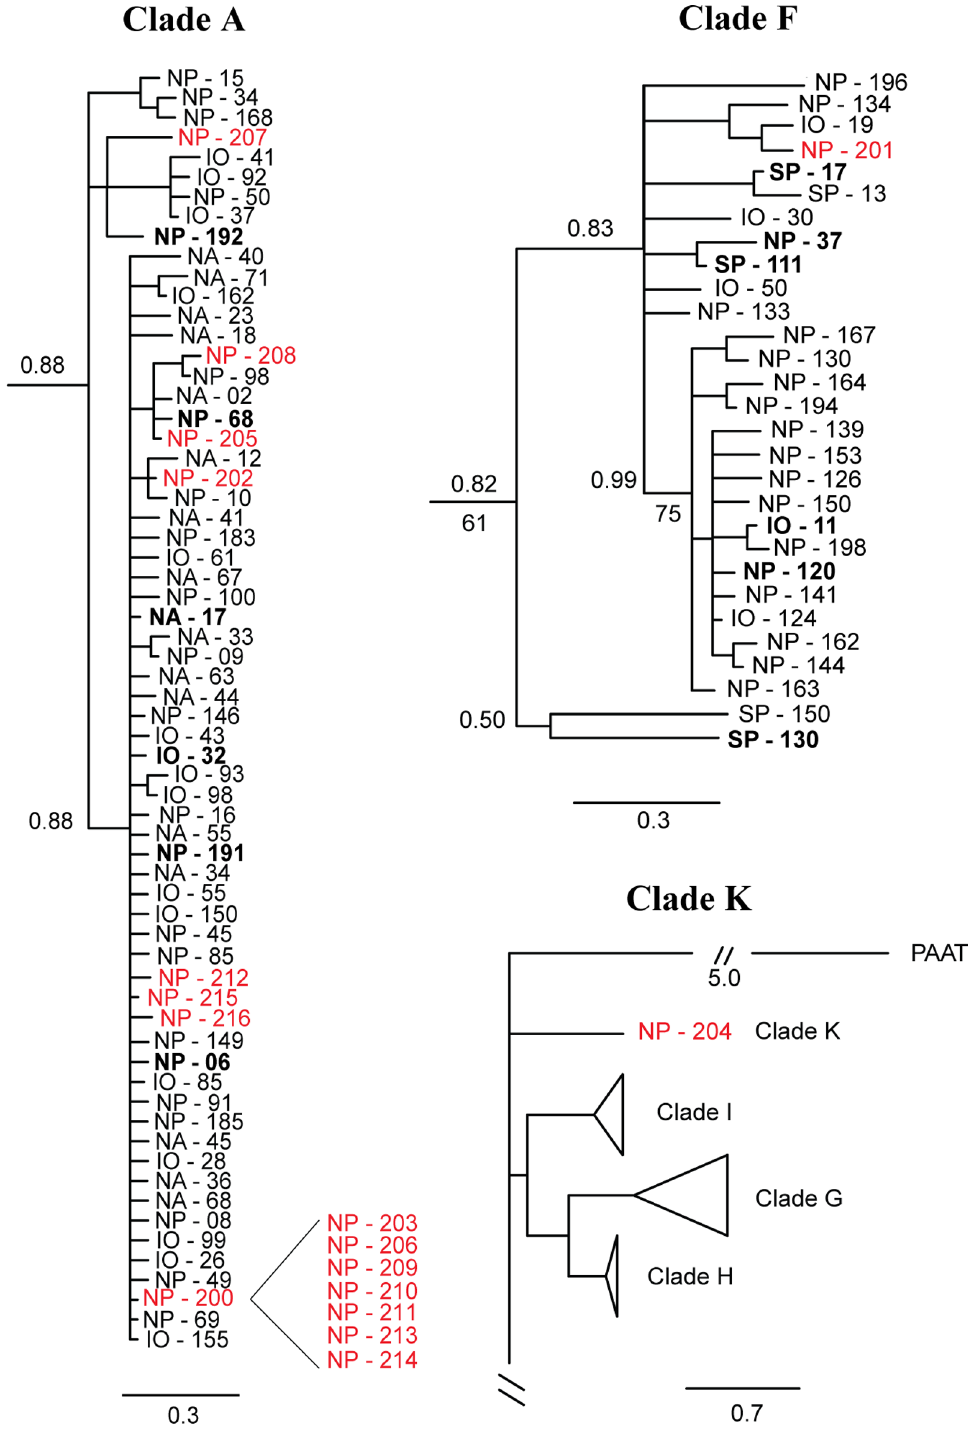
Figure 6. Placement of 17 cDNA mtCOII sequences in the Bayesian phylogeny of P.piseki–gracilis clades A, F, and K. cDNA sequences are marked in red font, and bold indicates haplotypes that were sampled more than once. The scale bar units are in substitutions per site. Relationships among the major clades are shown in figure 2.